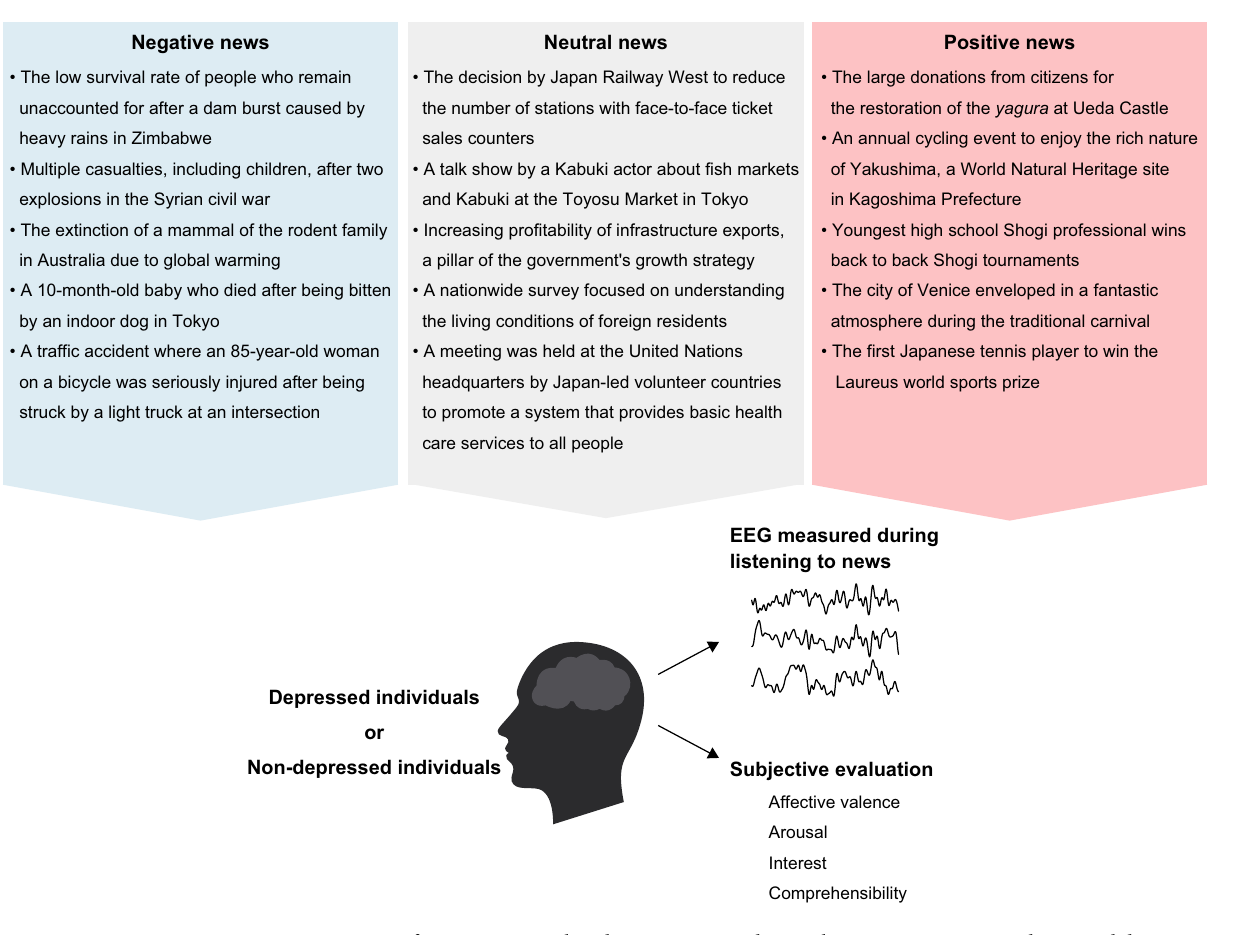
Figure 1. Summary of news contents played to participants during the EEG experiment and acquired data. Outlines of 15 news items (five for each positive, neutral, and negative news condition) selected are summarized at the top. In the experiment, EEG was measured while the participants were listening to the news. Immediately after, they evaluated the content on a 5-point scale: affective valence, arousal, interest, and